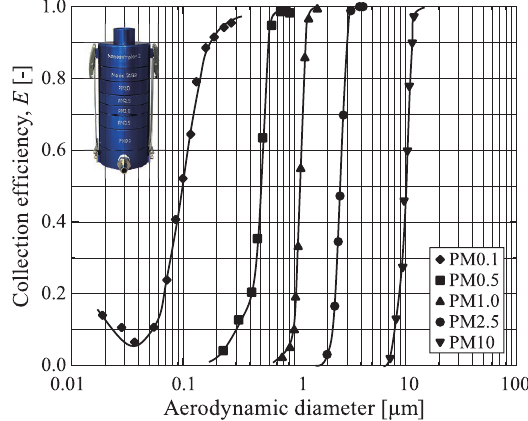
Fig. 4 Image of sub-micrometer particles captured on nanofi - bers. Fig. 5 Separation curves of Nanosampler with inertial filter stage for separating 0.1 μm (Kanomax, Model